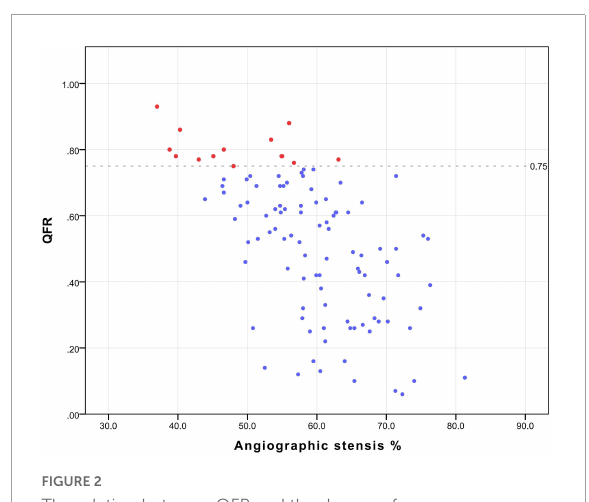
FIGURE2 The relation between QFR and the degree of coronary angiographic